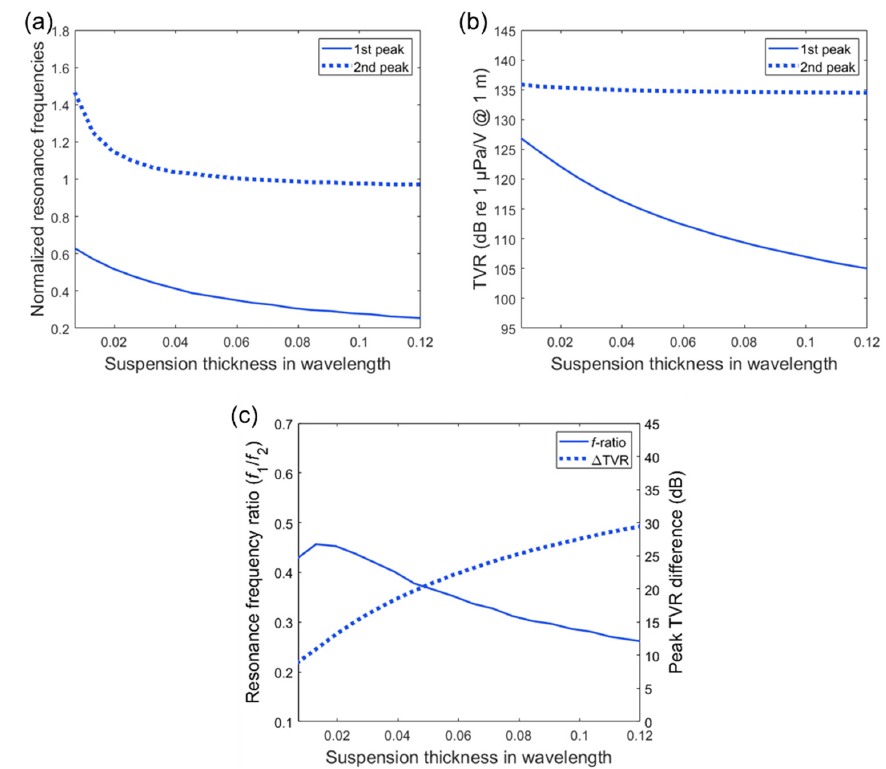
Figure 5. Transmitting characteristics as a function of suspension thickness. The thickness dimension is presented in wavelength and the frequency values are normalized by the fundamental longitudinal resonance frequency f 2 : ( a ) normalized resonance frequency variation; ( b ) TVR peak variation; ( c ) the variation in resonance frequency ratio ( f 1 / f 2 ) and TVR difference.